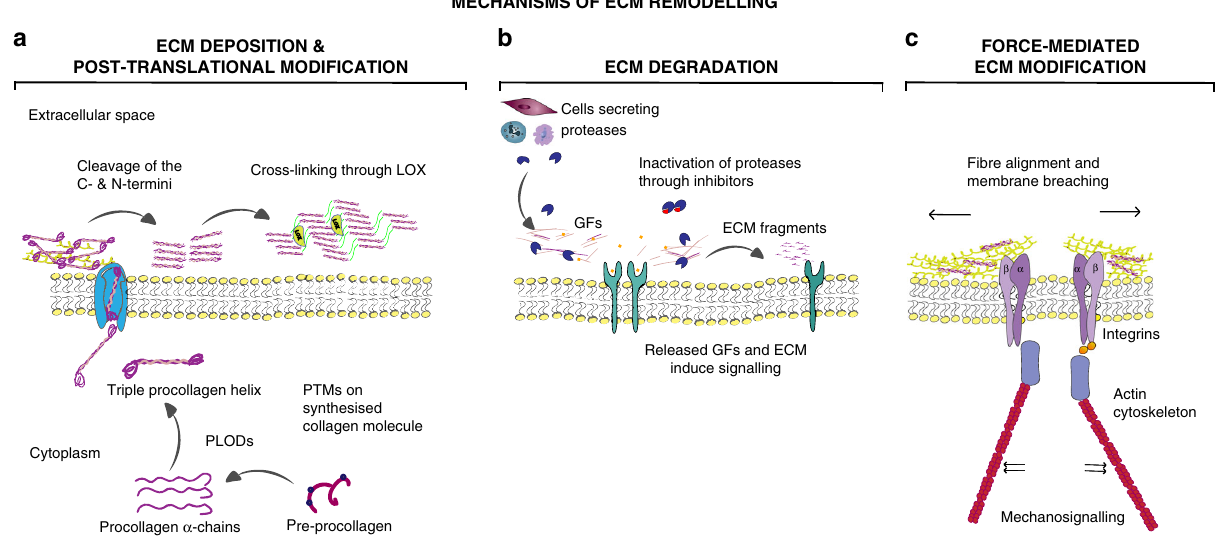
Fig. 1 Mechanisms of ECM remodelling. a ECM deposition and modi fi cation: using collagen as an example, pre-procollagen is synthesised and translocated to the Golgi, where it becomes a procollagen α -chain. This procollagen molecule undergoes several post-translational modi fi cations (PTMs) to modify its properties. The PTMs include glycosylation, pro-peptide alignment, disulphide bond formation and hydroxylation. Lysine hydroxylation of the procollagen chains by PLODs allows for spontaneous triple helix formation within the cell and secretion into the extracellular space. Here, the pro-peptides on the C- and N-terminal are cleaved by proteases creating collagen fi brils. For further collagen fi bre assembly, collagens fi brils are cross-linked by LOX. b ECM degradation: proteases including MMPs cleave the ECM proteins, which releases matrix-bound growth factors (GFs) and cytokines, and ECM fragments, including matrikines and also remove barriers for cell migration. c Force-mediated ECM remodelling: integrin binding to the ECM molecules applies forces to ECM molecules. This can change the conformation of the ECM molecule, thereby exposing binding sites to support self-assembly into fi brils that induces fi bre alignment. The mechanical force applied by the integrins in this modi fi cation process can also cause non-proteolytic breaching of the basement membrane that will allow cancer cell